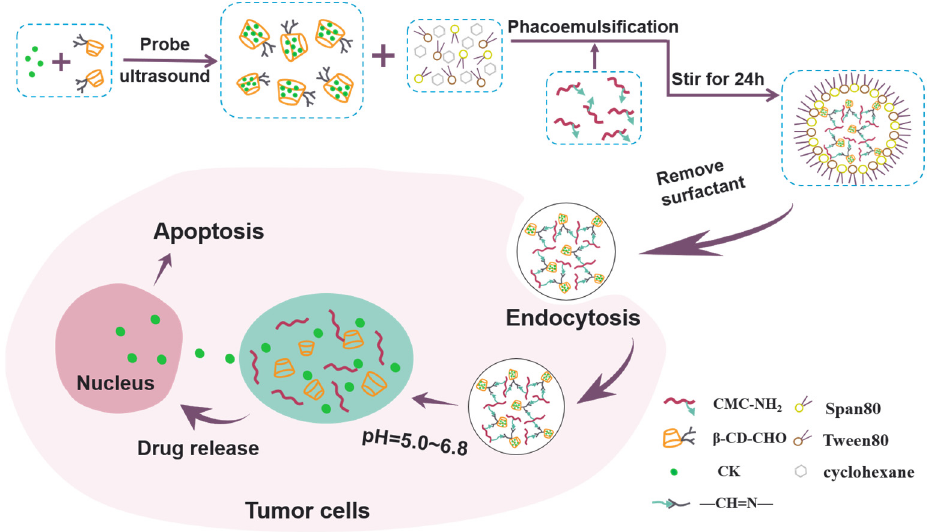
Figure 1. Schematic illustration of preparation of CMC- β -CD Ngs.